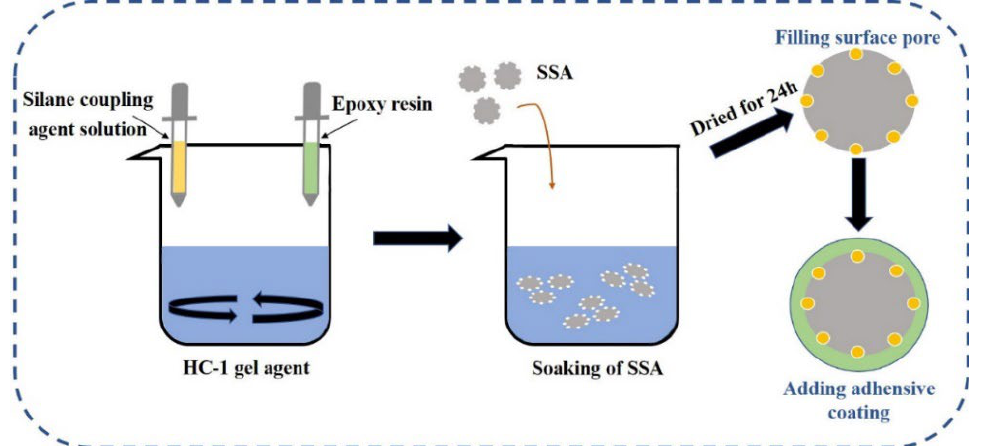
Figure 1. Surface treatment of SSA.